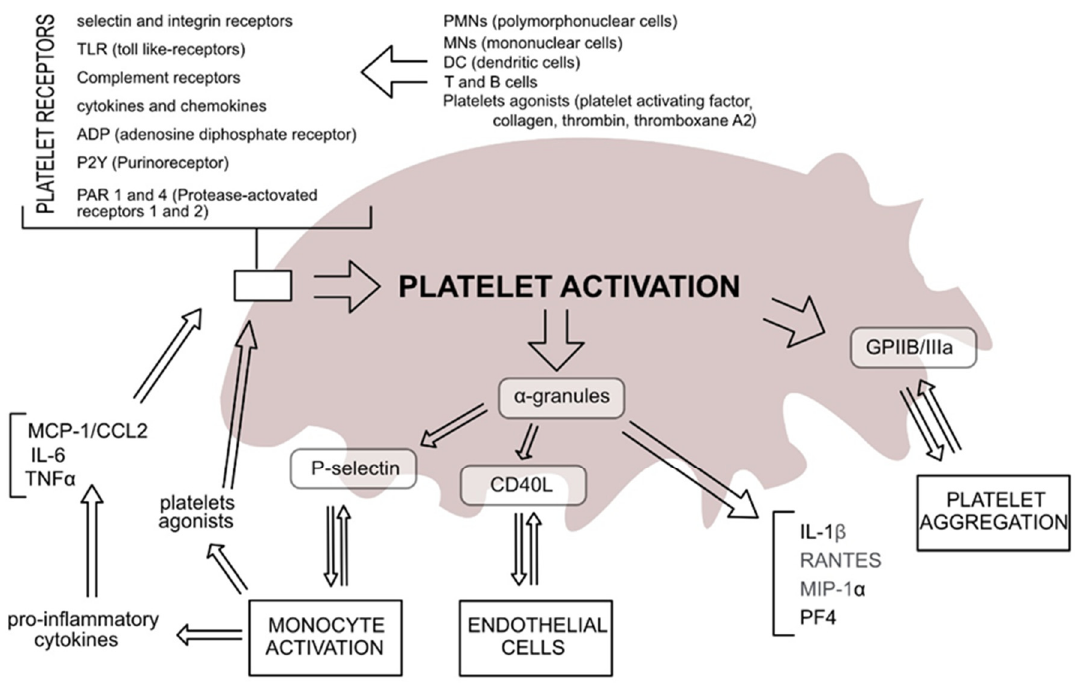
Figure 1. Molecular pathways involved in platelet activation during the inflammatory process.